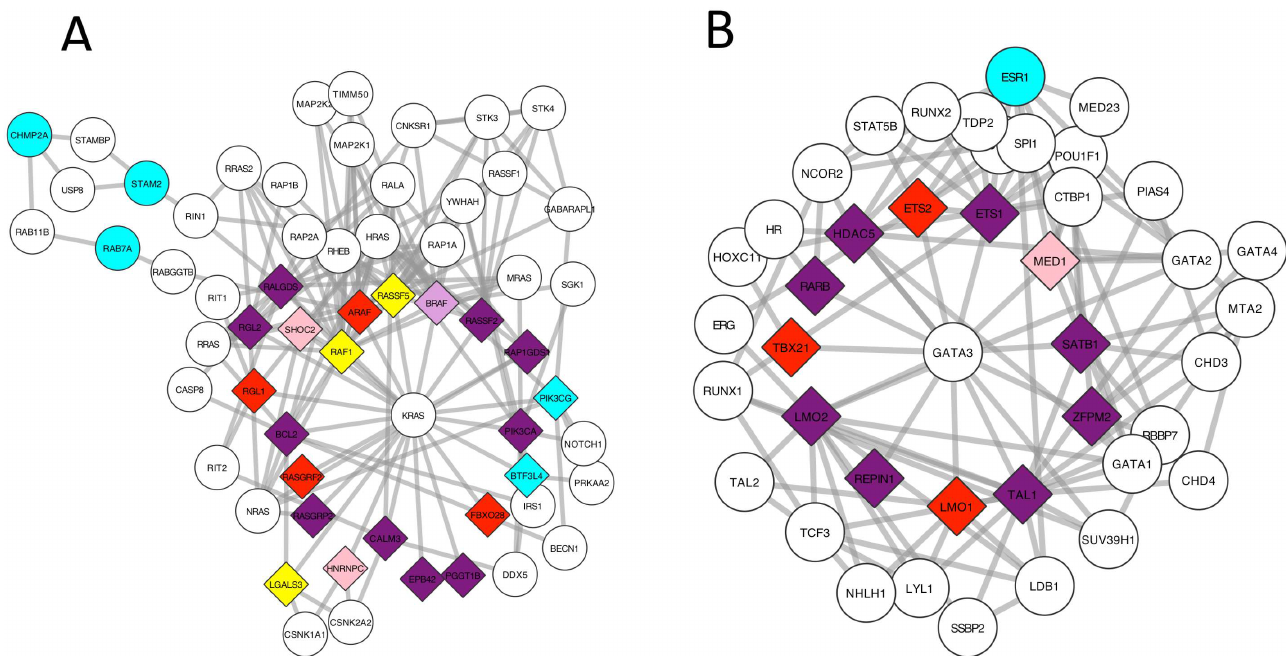
Fig 2. Results of Hotnet2 and Conflux on two Star-shaped disease subnetwork where the center is not a causal gene. A) KRAS centeredstar B) GATA3 centeredstar. The nodesin purpleare genes found by both Hotnet2 and Conflux. The nodes in cyan were only found by Hotnet2. The nodesin red and pink are respectivelynodesdetected (marginal (cid:21) 0.2) or havingsuggestiveevidence(marginal (cid:21) 0.05) by Conflux. Nodes coloredin plum were found by Hotnet2 but only have suggestiveevidencein Conflux.Yellow nodes are true causal genesthat were neither found nor suggested by any method. The diamondshapednodes are the true causal genes. The sample size used is n = 800.